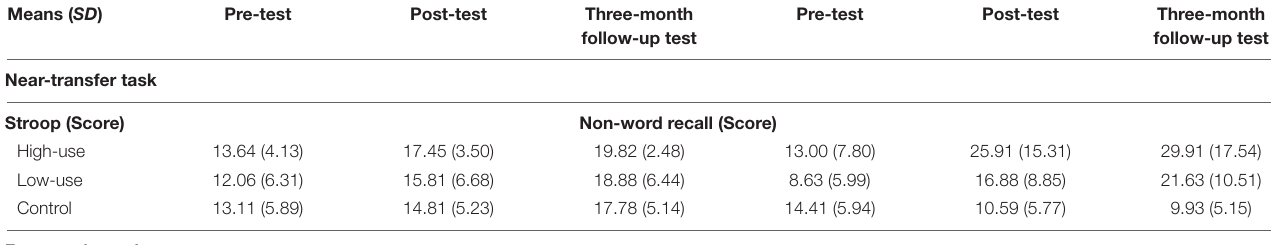
TABLE 10 | Means (standard deviations) of near transfer tasks in Experiment